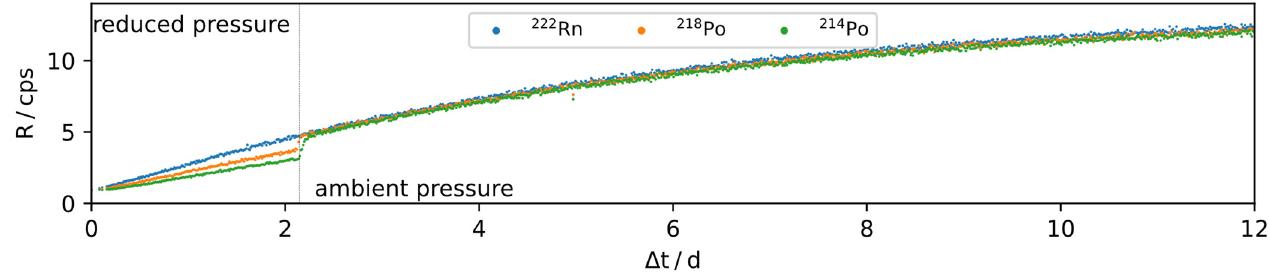
Figure 6. Ingrowth of α -particle count rates of an IRSD after initial 226 Ra deposition at reduced and ambient pressure.